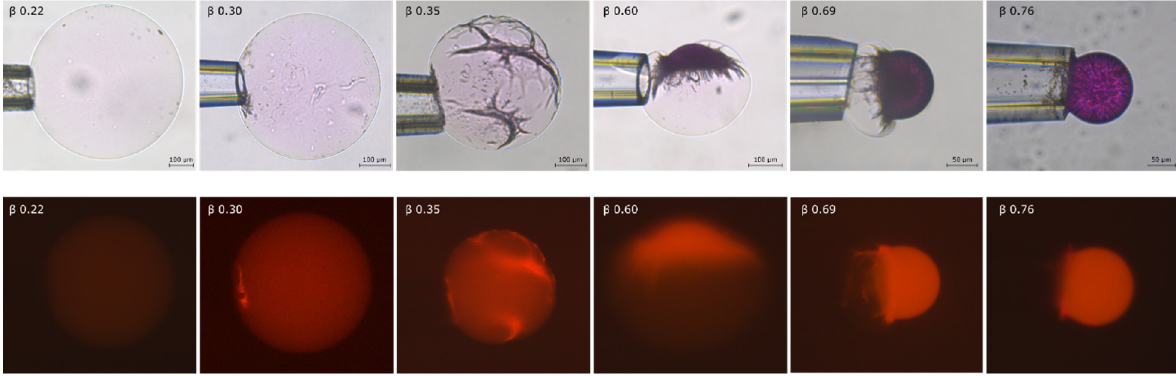
Figure 3. Light microscopy images ( upper row ) and fluorescence images ( lower row ) of polyacrylate microgels after equilibration in a limited volume of AMT solution. Each binding ratio represents a separate experiment.